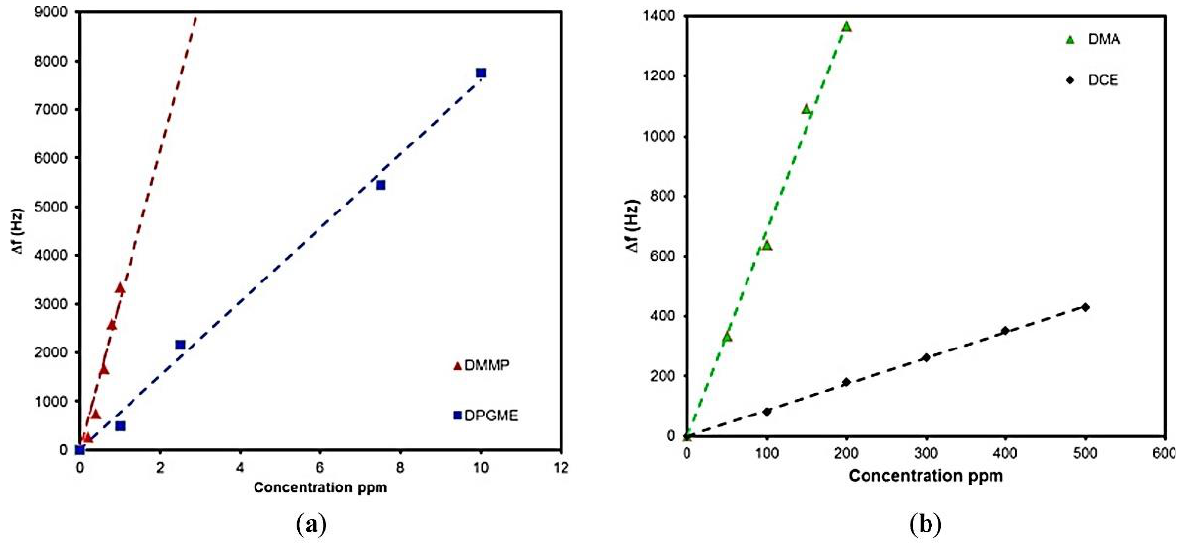
Figure 9. Response versus concentration plots of graphene oxide Love wave sensor for ( a ) DMMP and DPGME, and ( b ) DMA and DCE [74]. Reprinted with permission from [74]. Copyright 2016 Elsevier.